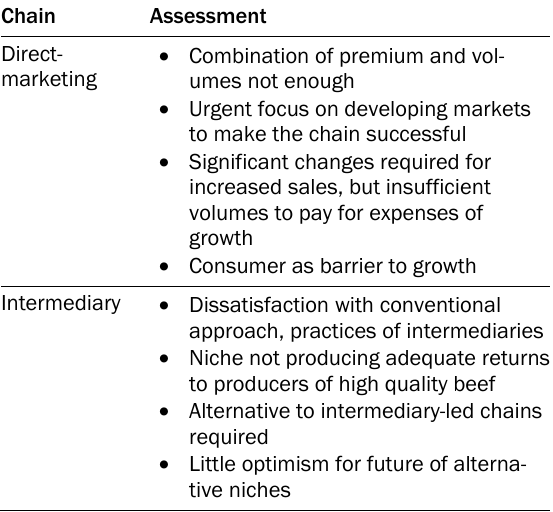
Table 5. Key Findings by Market